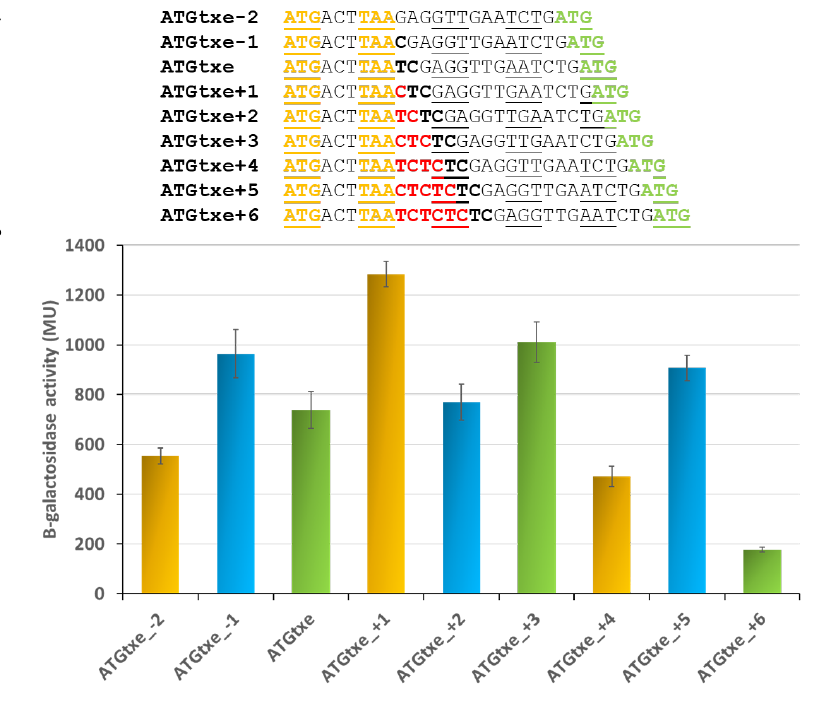
Figure 5. The reading frame and distance between the minigene and the downstream cistron play a role in regulation of txe translation. ( A ) Nucleotides that were deleted in two derivatives are indicated in black bold, while inserted nucleotides are displayed in red bold. Codons in the same reading frame as ATG2 (yellow) are underlined. ( B ) β -galactosidase activities were assessed in the E. coli ∆5∆lac strain carrying pRW225 derivatives, as indicated on the graph. Reporter activity was measured when cell cultures reached OD600 ≈ 0.5. The same colors are kept for the same open reading frame. These results are the average of at least three independent experiments; error bars represent standard deviation (S.D.). The p -values calculated for two constructs in the same reading frames (yellow and green) showed statistical significance ( p < 0.05), in contrast to those indicated with blue bars where no statistical differences were found between